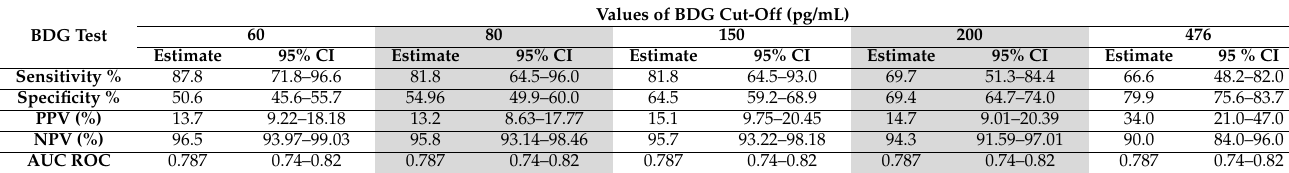
Table 2. Diagnostic performance of BDG at different cut-offs.